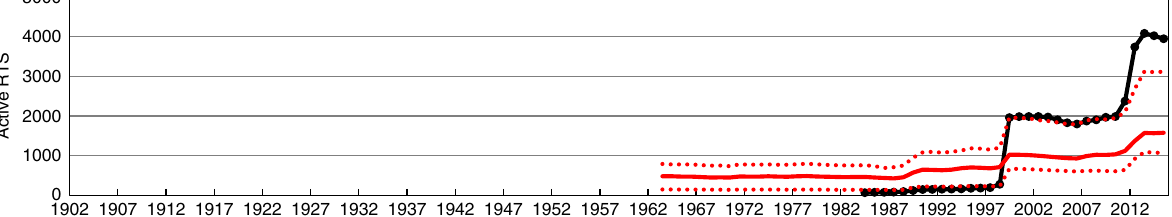
Fig. 8 Summer air temperatures and hindcast retrogressive thaw slump activity. a 2-year weighted mean July – August air temperature (derived from the Hadley CRU dataset 52,53 ) for Banks Island (1902 – 2015); dashed line is a 5-year centred running mean. Note: lower variance for 1901 – 1925 is due to constant values appearing in the Hadley CRU dataset for the northern part of the island for this period. b Hindcast retrogressive thaw slump initiation for 1902 – 2015 using the climate data in a and the relation in Fig. 2d. Error bars are 95% con fi dence intervals, shaded area represents prediction intervals, and red points are observed values. c Total number of retrogressive thaw slumps active on Banks Island (1964 – 2015). Solid red line was hindcast using initiation numbers in b and longevity relation in Fig. 3a. Dashed red lines are predictions made using upper 95% con fi dence interval for initiation and for longevity (Fig. 3a) and with lower 95% con fi dence interval for initiation and longevity. Black line is observed total number of active retrogressive